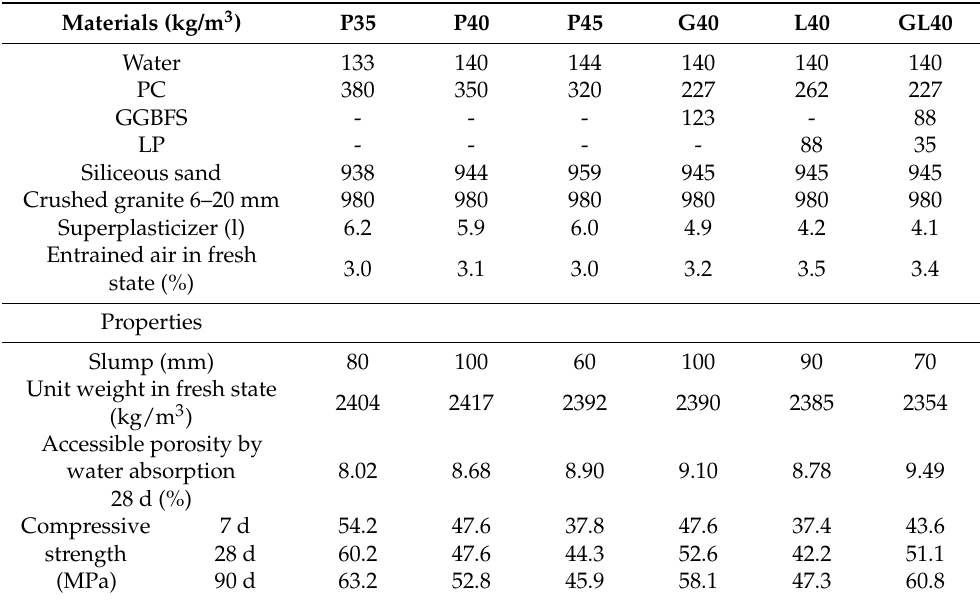
Table 1. Mix proportions and properties of concretes.